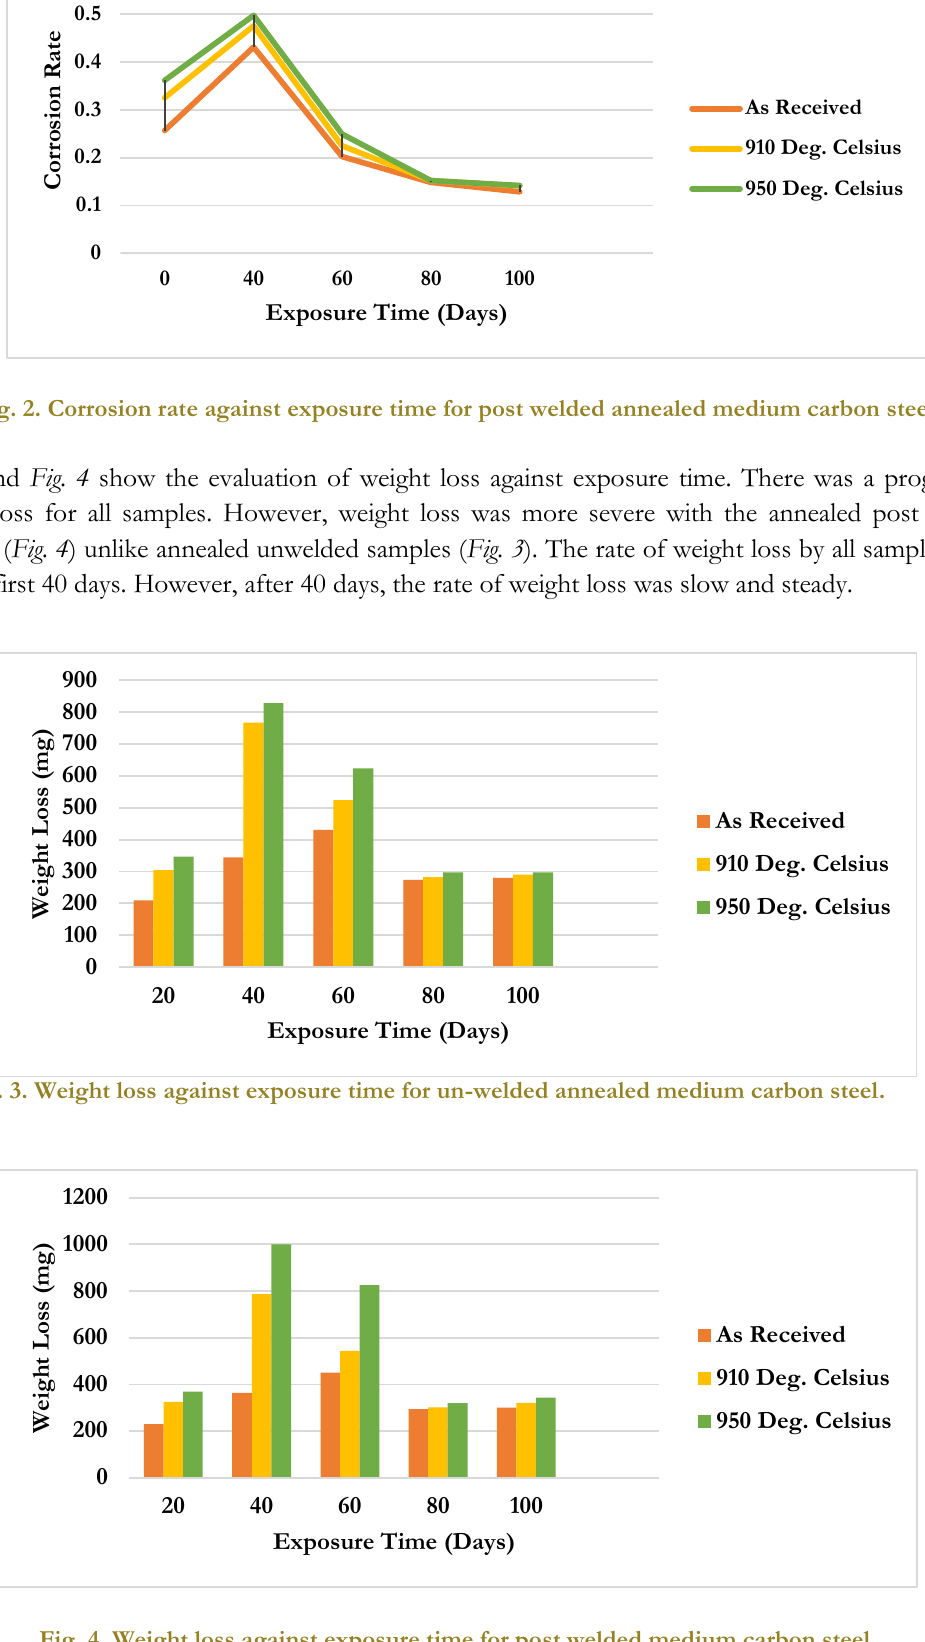
Fig. 4. Weight loss against exposure time for post welded medium carbon